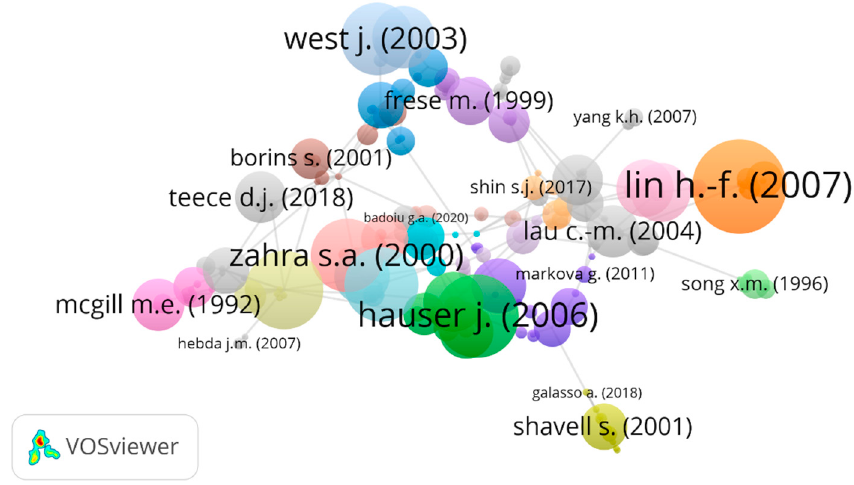
Figure 7. Network analysis based on citation. Source: created by the authors . The identified keywords were investigated using the tool VOSviewer to detect their interconnections. It is possible to observe the development of the topic and deduce new perspectives. The results can be seen in Figure 8.